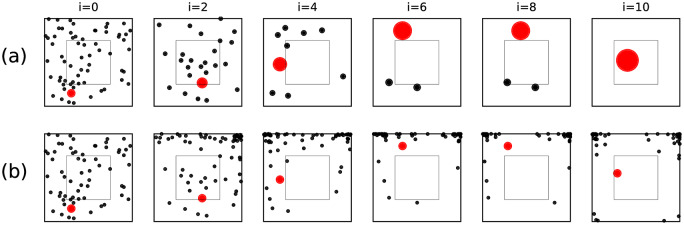
Linear and nonlinear zooming.A 2D Horstein-zooming interface using linear and non-linear zooming displays (every second step shown). Targets are shown as black points, with the intended target shown as a larger red marker. (a) Linear zooming, where the geometry of points is fixed, and the view spans an interval of constant density. (b) Non-linear zooming, where the inverse PDF is directly applied to points in a 2D space, pushing unlikely points to the edges of space, always showing the entire unit interval.